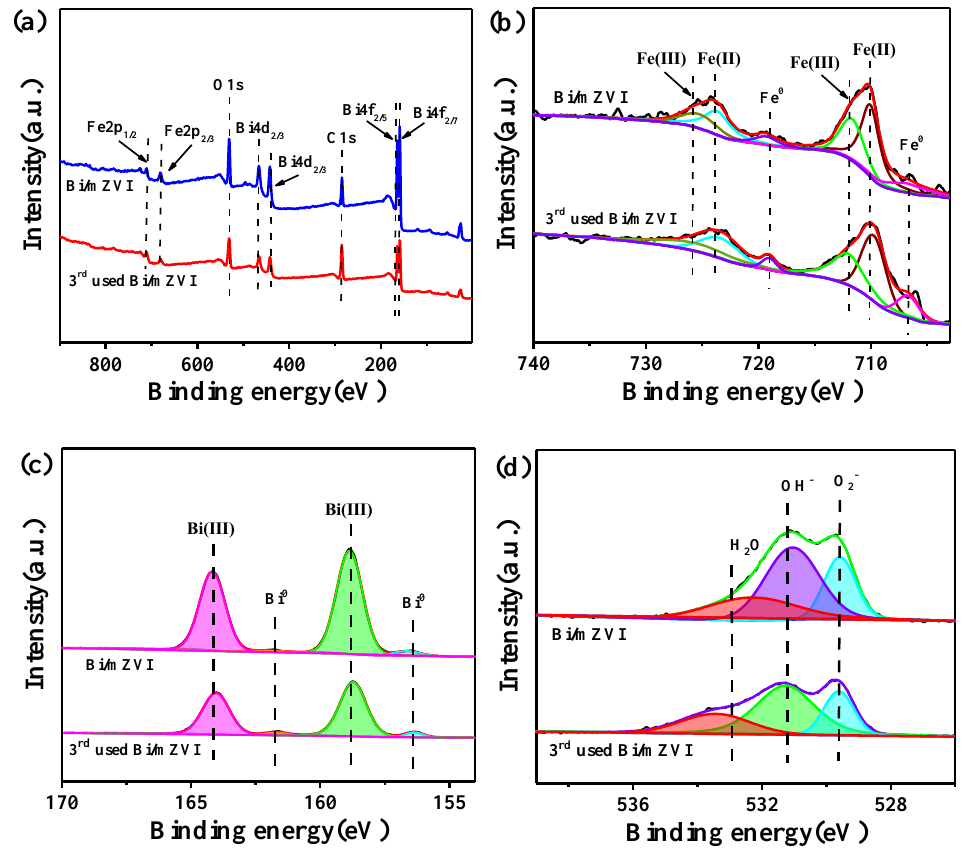
Figure 2. ( a ) Full XPS region of survey; high-resolution XPS spectra of ( b ) Fe 2p region ( c ) Bi 4f region and ( d ) O 1s region for the Bi/mZVI and 3 rd used Bi/mZVI .